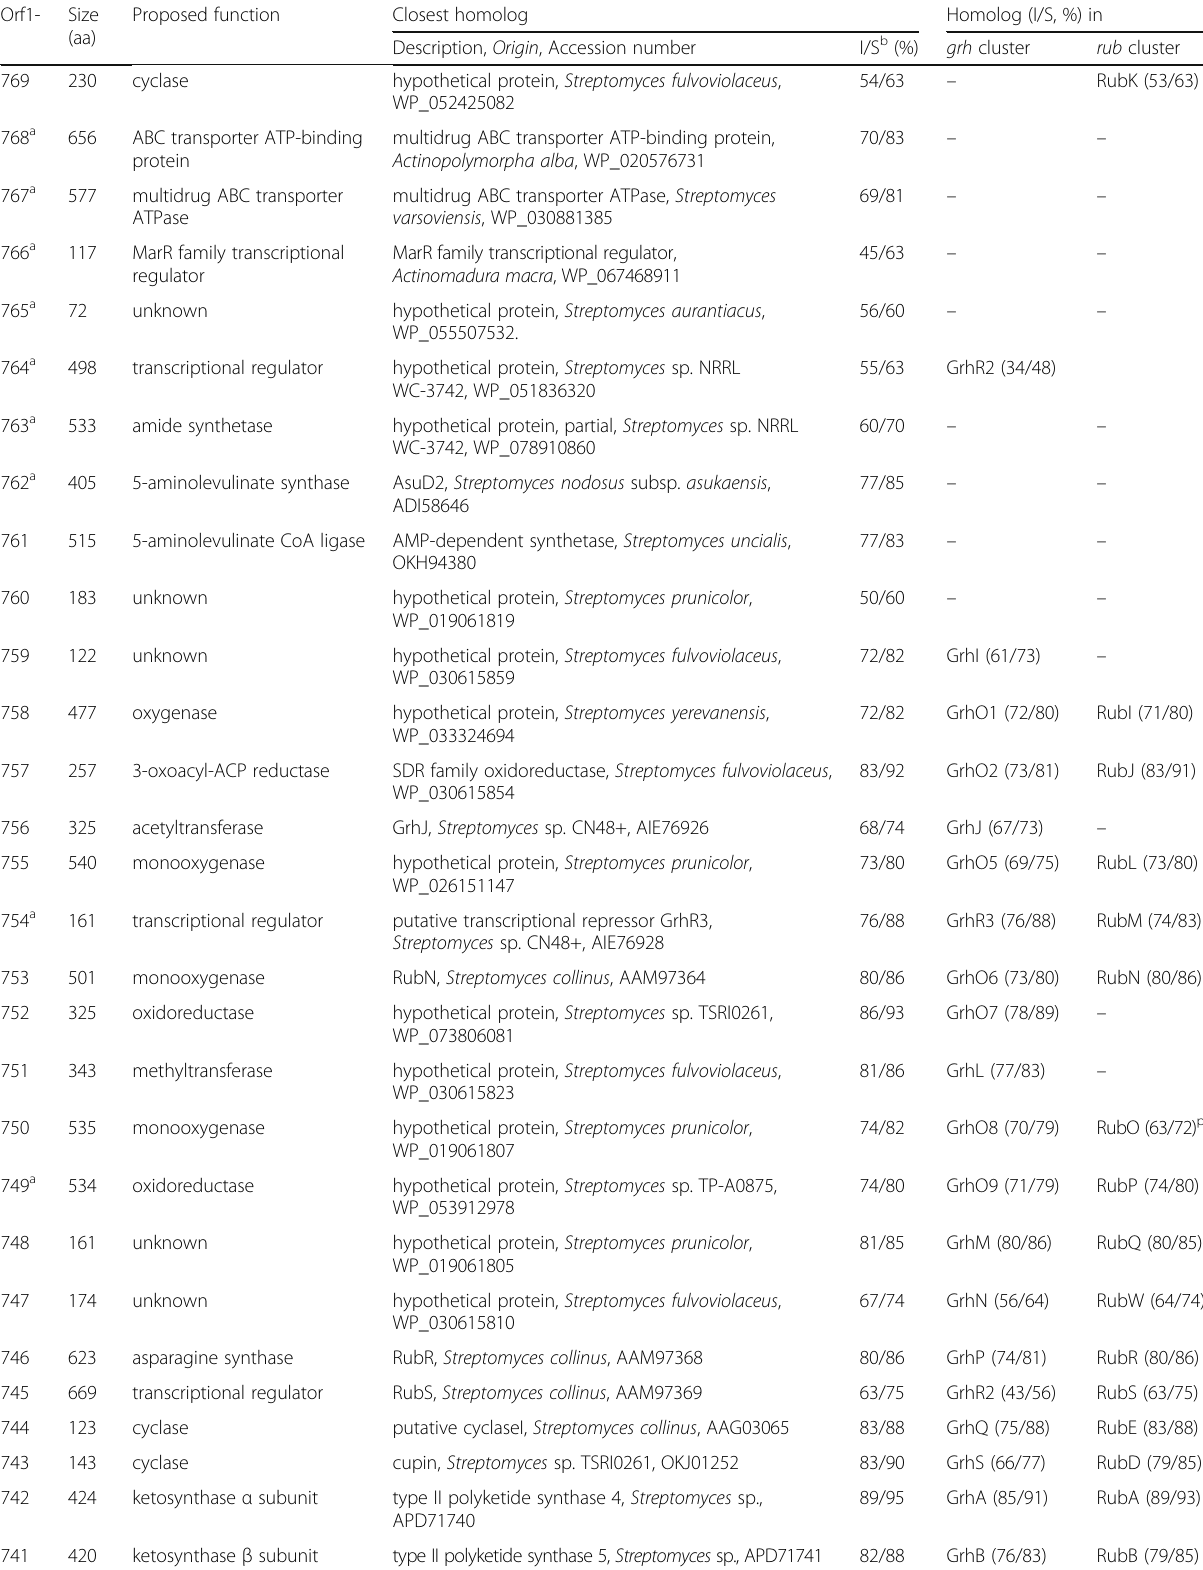
Table 5 Putative hyaluromycin biosynthetic gene cluster and the neighboring